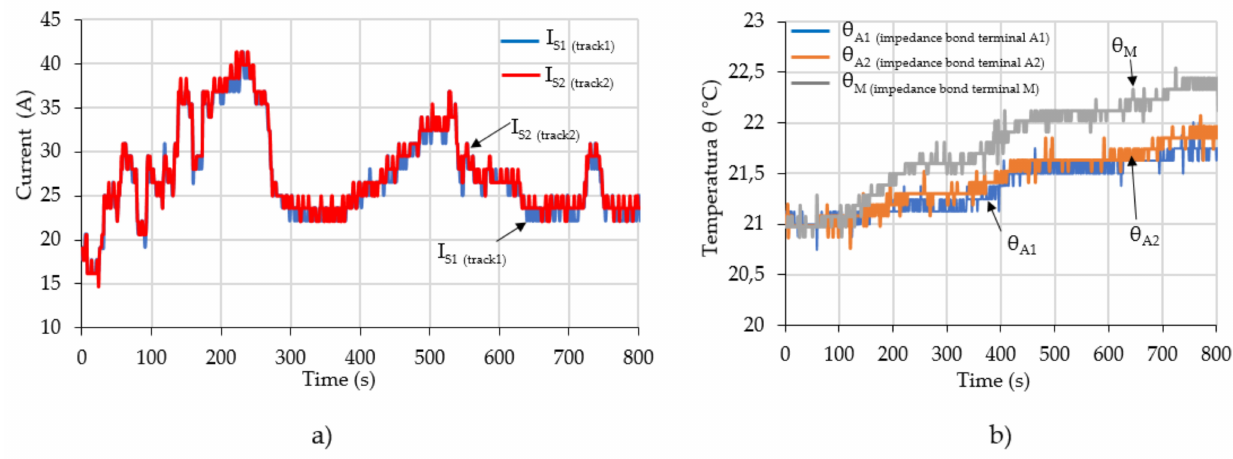
Figure 13. Monitoring the return circuit: ( a ) Currents evolution; ( b ) temperatures